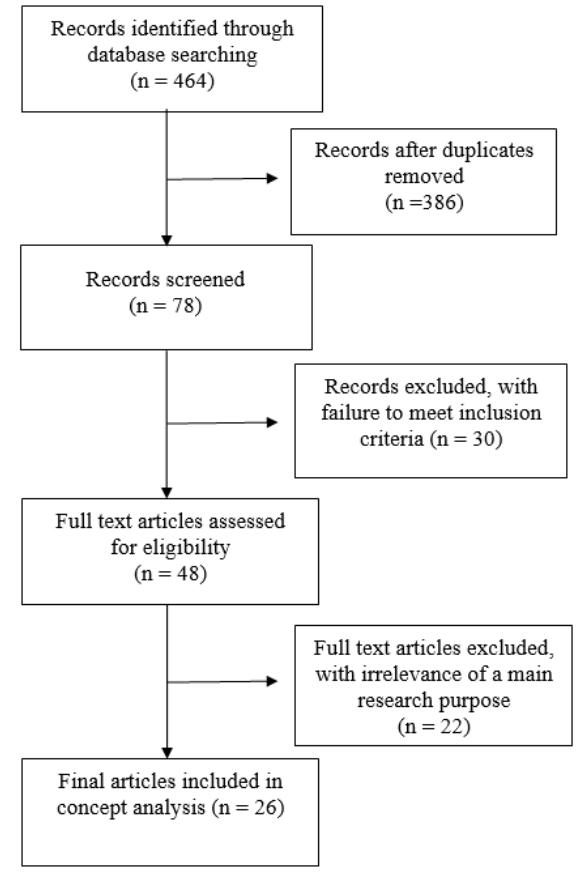
Figure 1. Flow diagram.